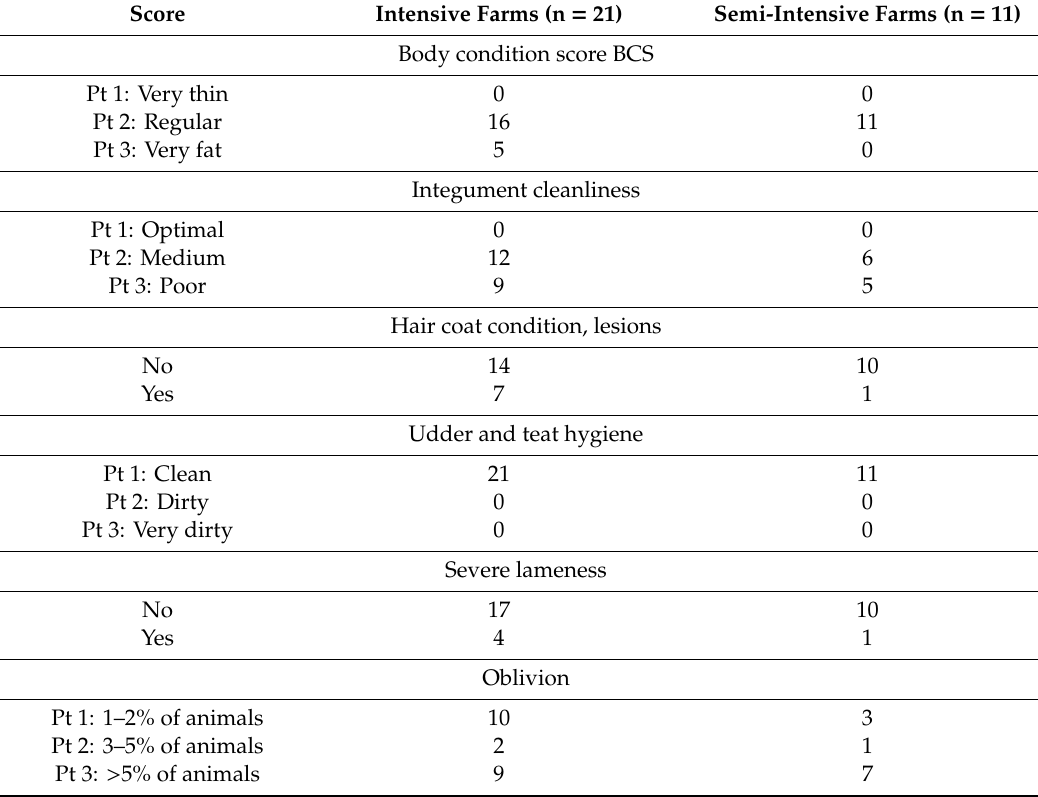
Table 2. Animal-based measures scored in intensive and semi-intensive goat farms, Northwestern Italy. Score Intensive Farms (n = 21) Semi-Intensive Farms (n = 11) Body condition score